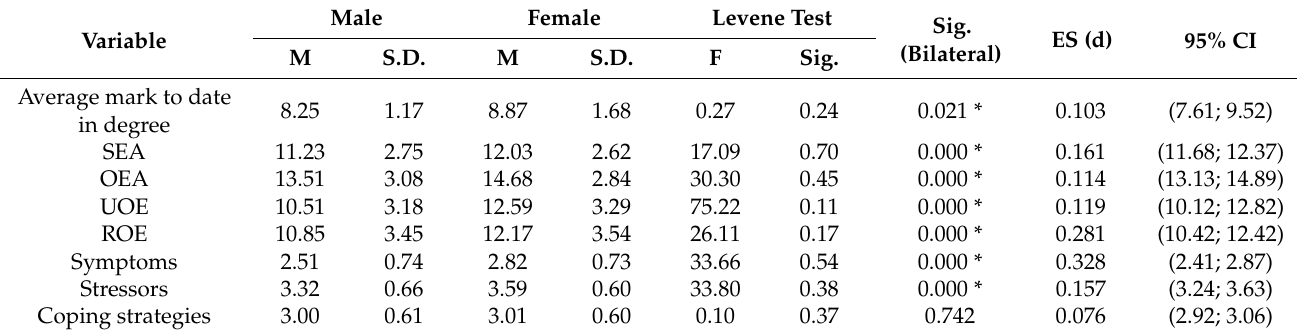
Table 1. Average mark to date in degree, emotional intelligence, and academic stress according to gender. Variable